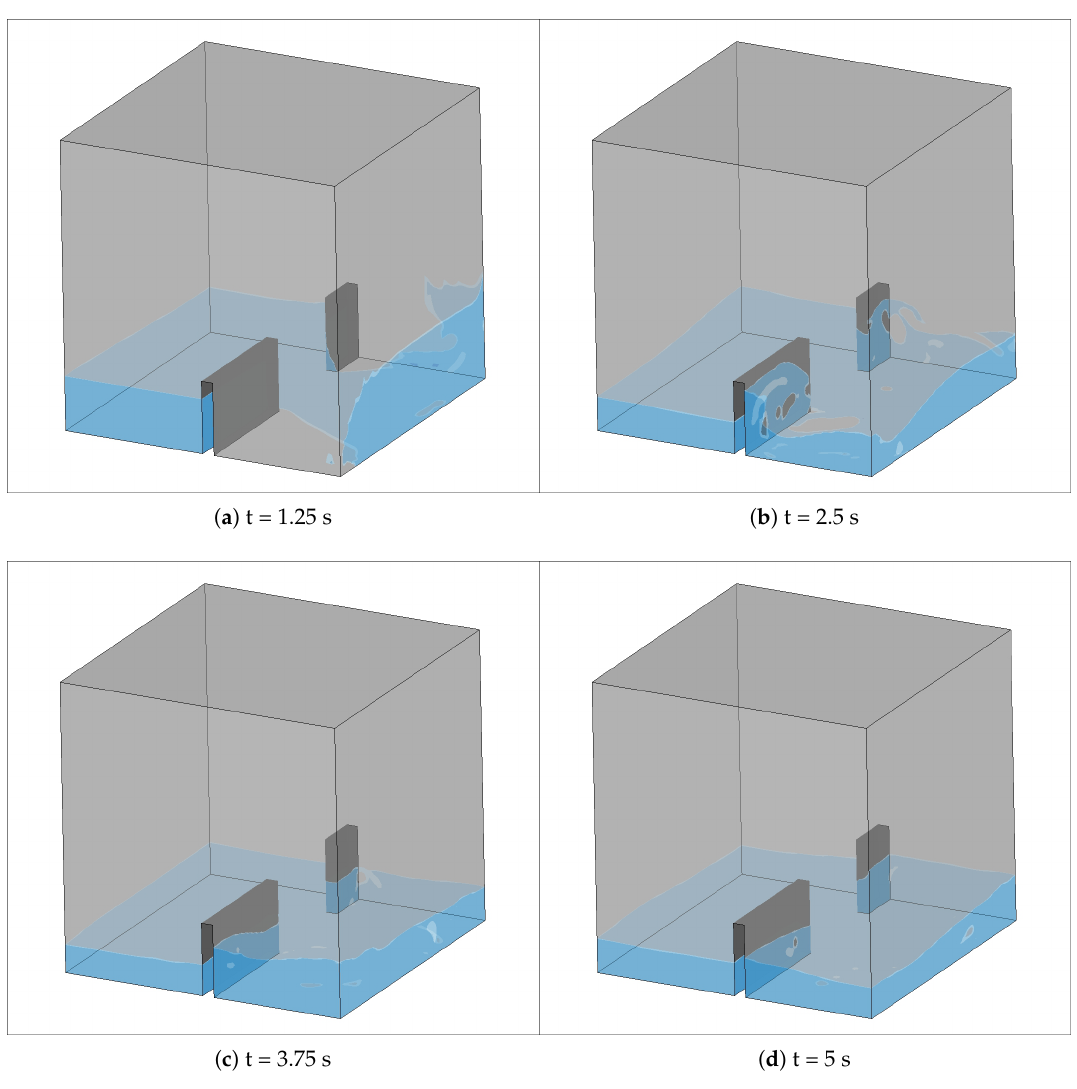
Figure 19. Water surface at different times. Table 10. Results of tests on a 3D damBreak